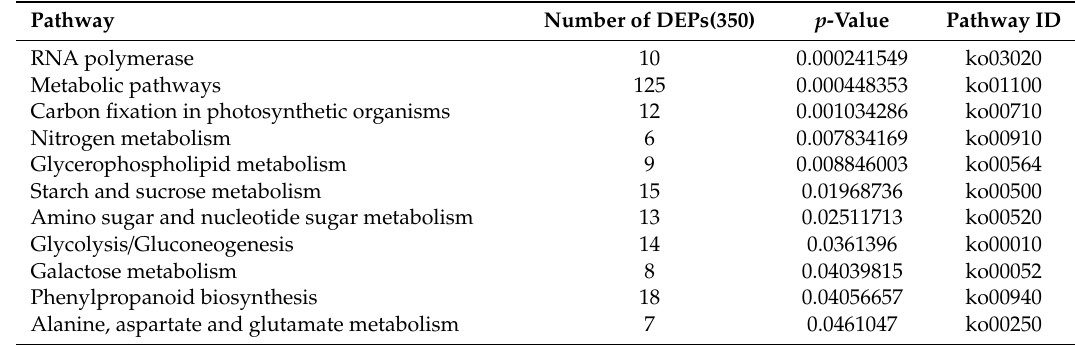
Table 2. Significant enrichment analysis of DEP Pathway in TD vs. TCK ( p < 0.05).